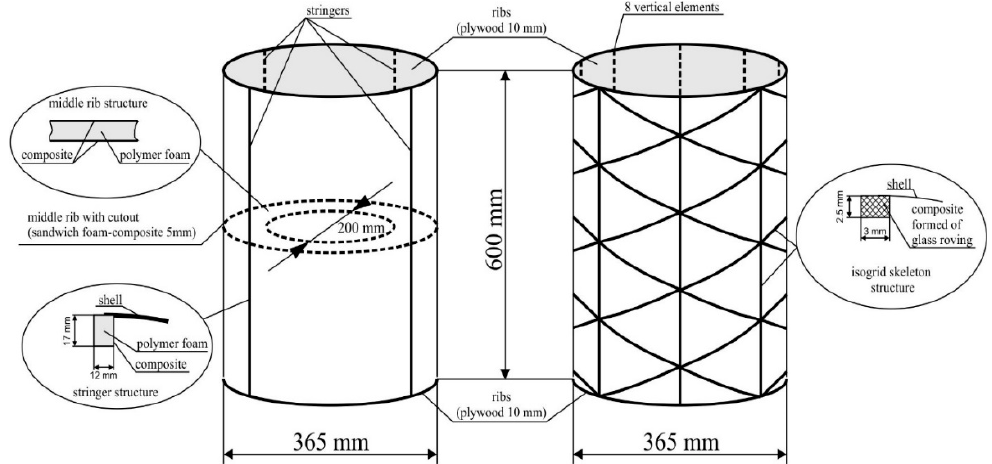
Figure 2. Schemes of models for experimental research: reference structure (on the left), structure with isogrid stiffener (on the right).